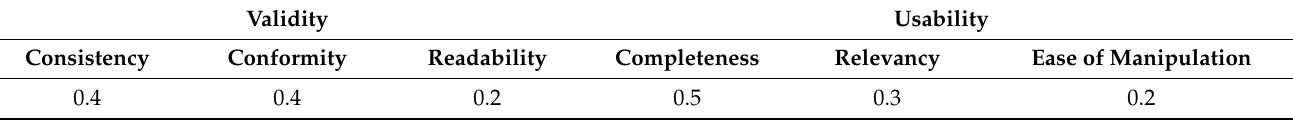
Table 9. Metrics Weights 2.